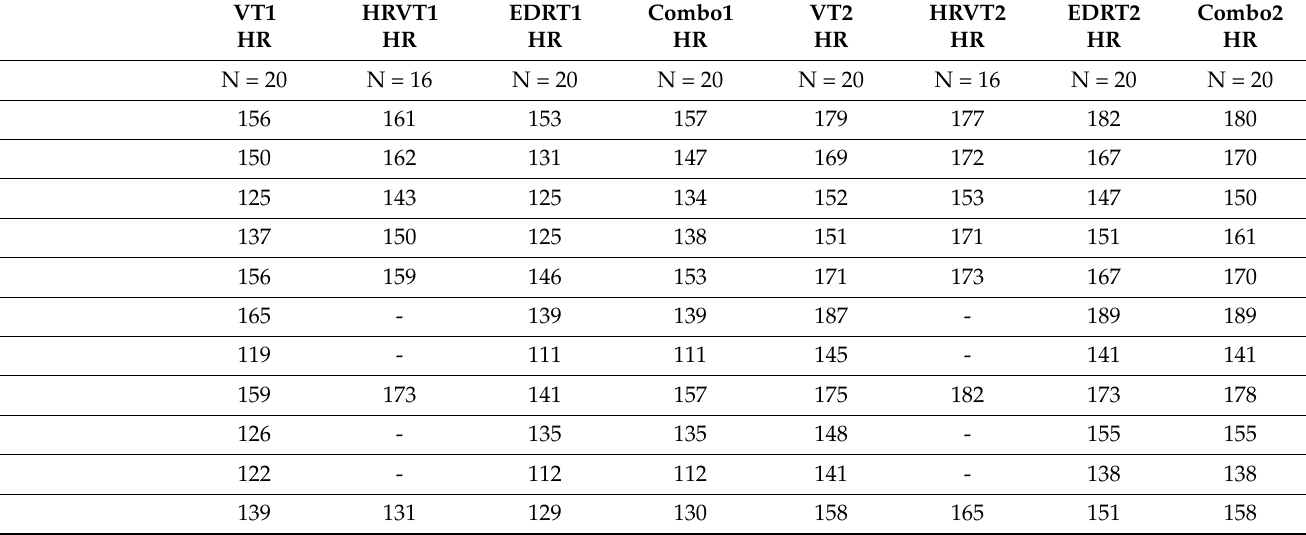
Table 2. Individual results for VT1, HRVT1, EDRT1, Combo1, VT2, HRVT2, EDRT2, and Combo2 with participant numbers during the incremental test. Mean, standard deviations (SD), Pearson’s r (vs. ventilatory derived thresholds), p value for t testing (vs. ventilatory derived thresholds) in last